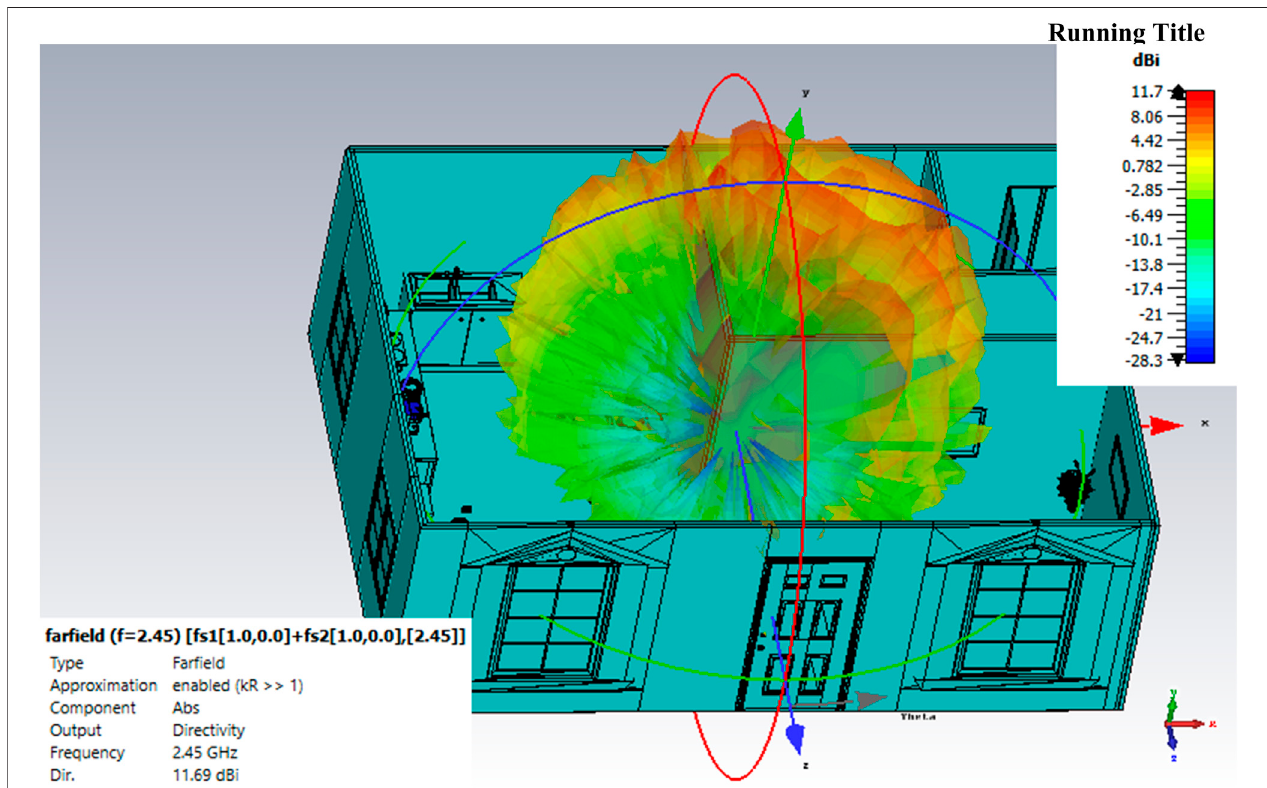
FIGURE 12 | Radiation pattern for hybrid design (2 wireless and 10